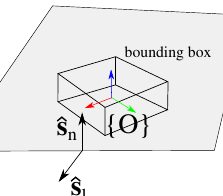
Figure 9. The bounding box of the “pill box”, the normal vector ˆ s n of the supporting surface, and the ˆ s l vector perpendicular to the edge of the supporting surface that is closest to the